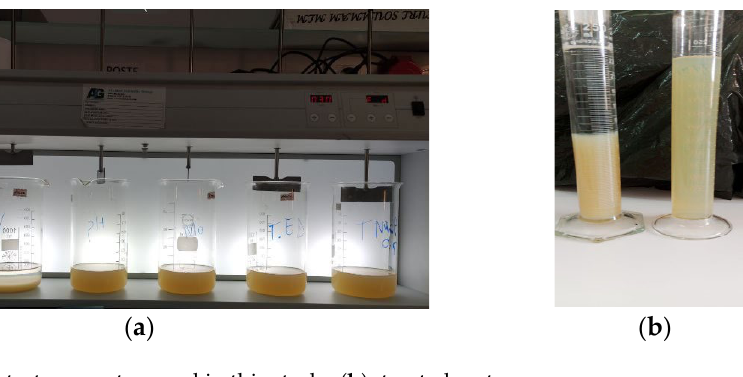
Figure 2. FTIR analysis of the studied bio-coagulants.